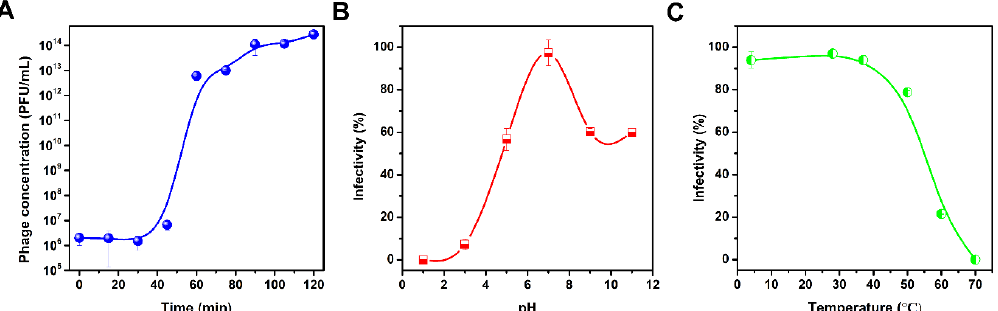
( B ) Tolerance of the phage to di ff erent pH treatments. ( C ) Thermal tolerance of the phage. For each test, the titer of the phage was tested by three replicates, and the mean value was used. The standard deviation of each datum is